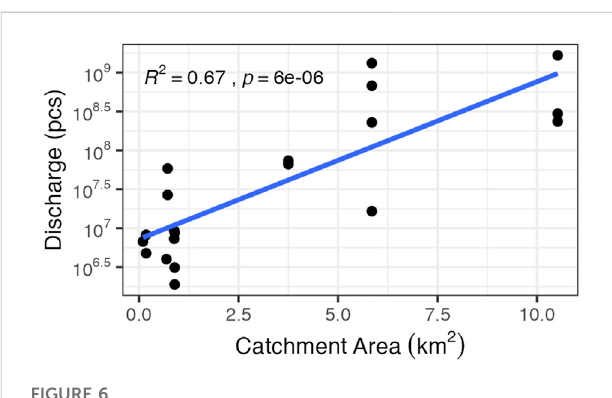
FIGURE 6 Linear regression between microplastic discharge and total catchment